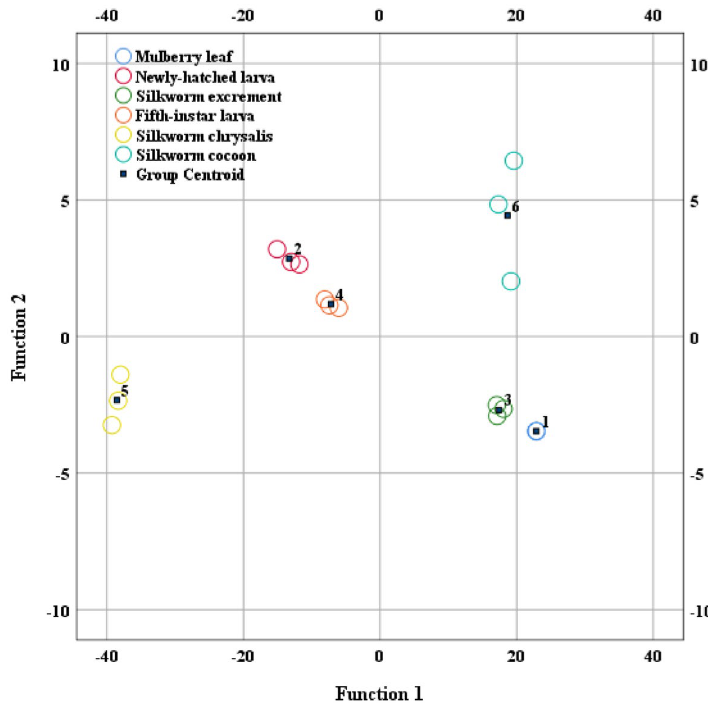
Figure 10. Discriminant analysis of